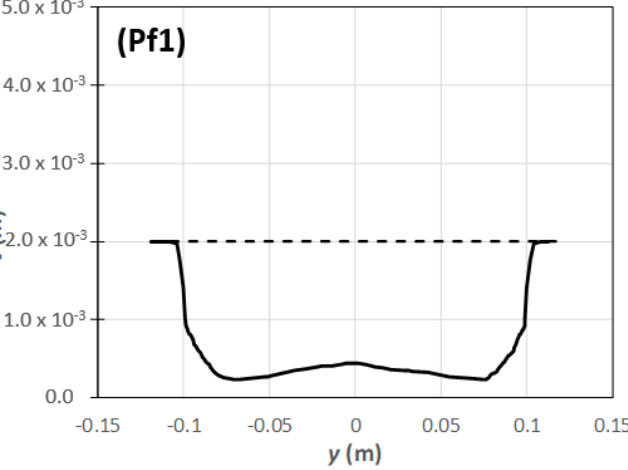
Figure 14. Thickness profile for solution Pf1 (Figure 9): dashed line is the constant sheet thickness and the continuous line the part thickness profile a x = 0.